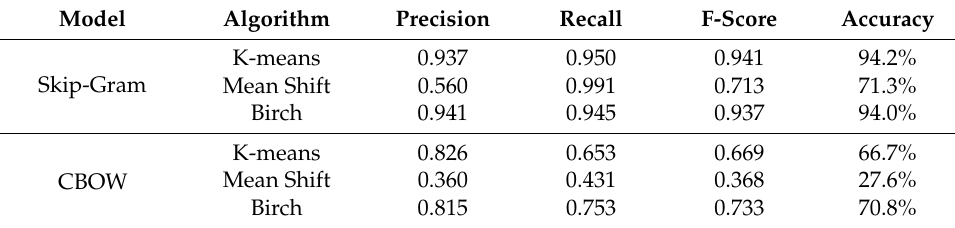
Table 4. Summary for clustering with entity embedding models on the training dataset.